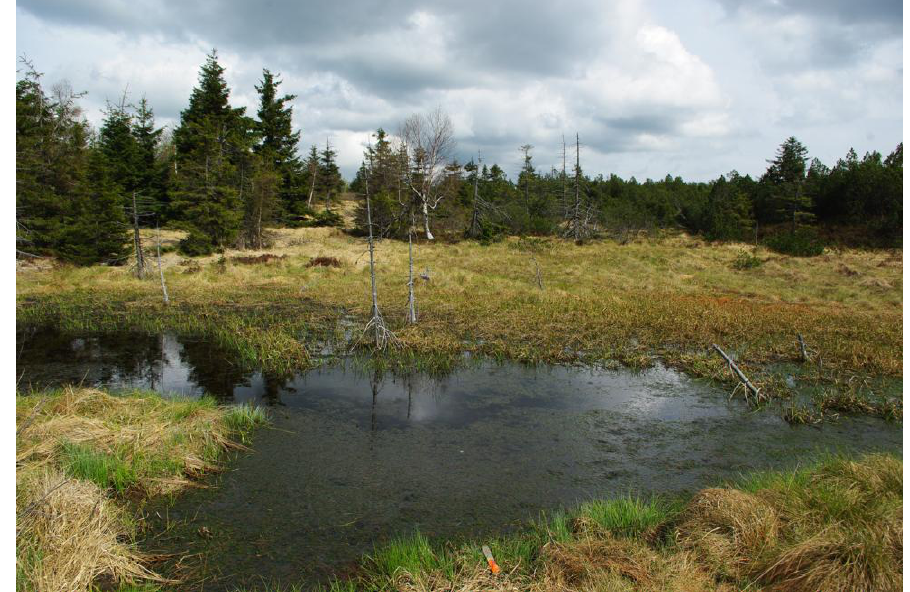
Figure 3: The Georgenfeld raised bog – view from the nature trail (photo O.